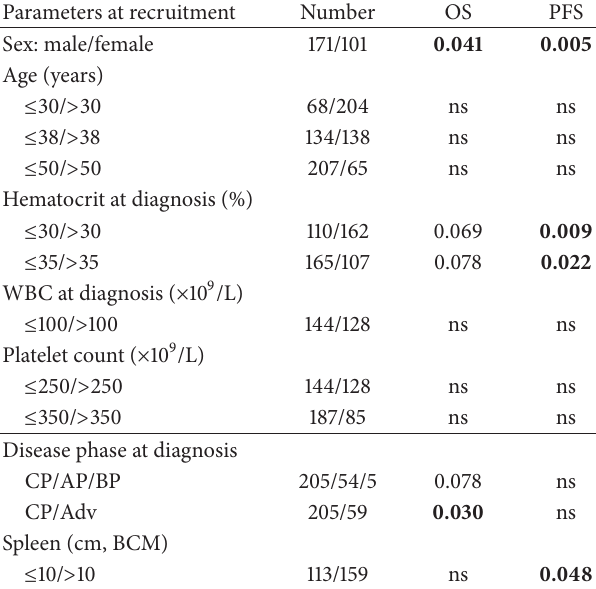
Table 3: Univariate analysis of all 272 patients’ characteristics as predictors of overall and progression-free survival.